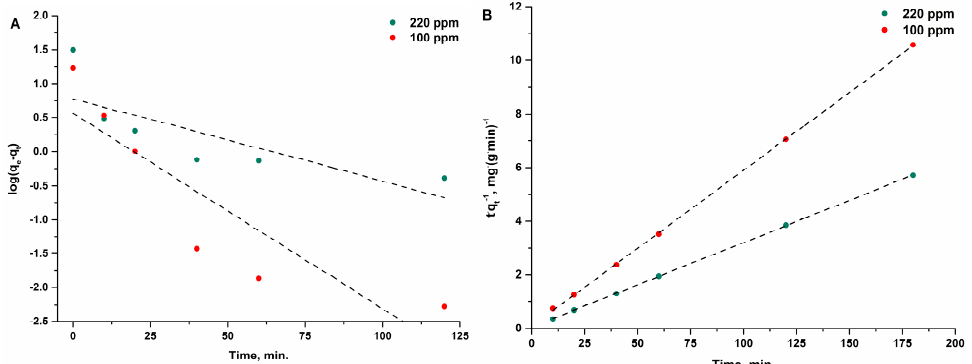
Figure 8. Pseudo-first- ( A ) and second-order ( B ) kinetic fit for adsorption of copper(II) ions onto R-SiO 2 -2h hybrid material. (T = 313.15 K, S:L = 4 g · dm − 3 , pH = 5). Table 3. Pseudo-first- and second-order kinetic parameters obtained by linear method for adsorption copper(II) on R-SiO 2 -2h hybrid material.